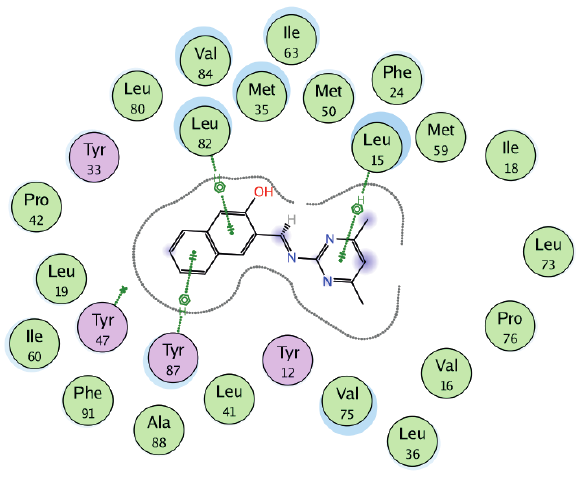
Figure 11: 2D Ligand Interactions between 1LRI and HL.